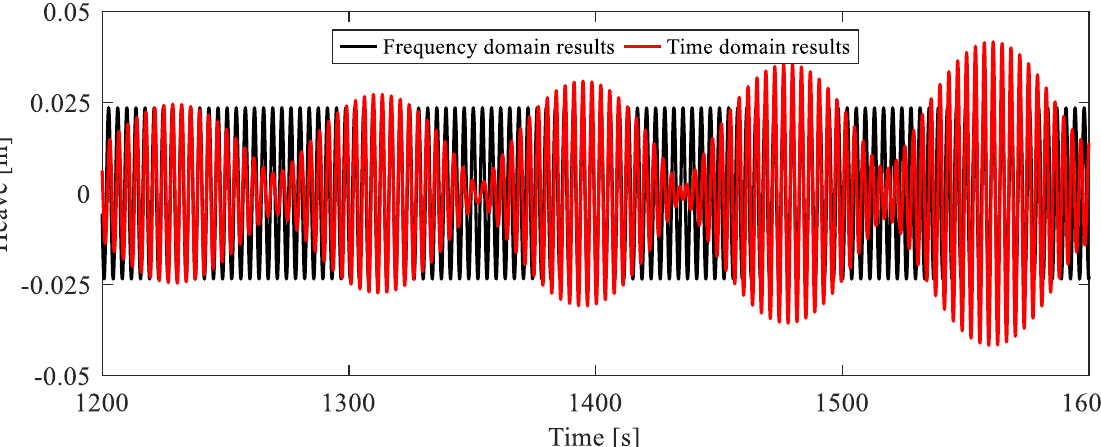
Figure 16. Comparison of windward module heave motions between frequency-domain results and time-domain results subjected to the regular wave ( H = 1 m, ω = 1.7 rad/s, α =